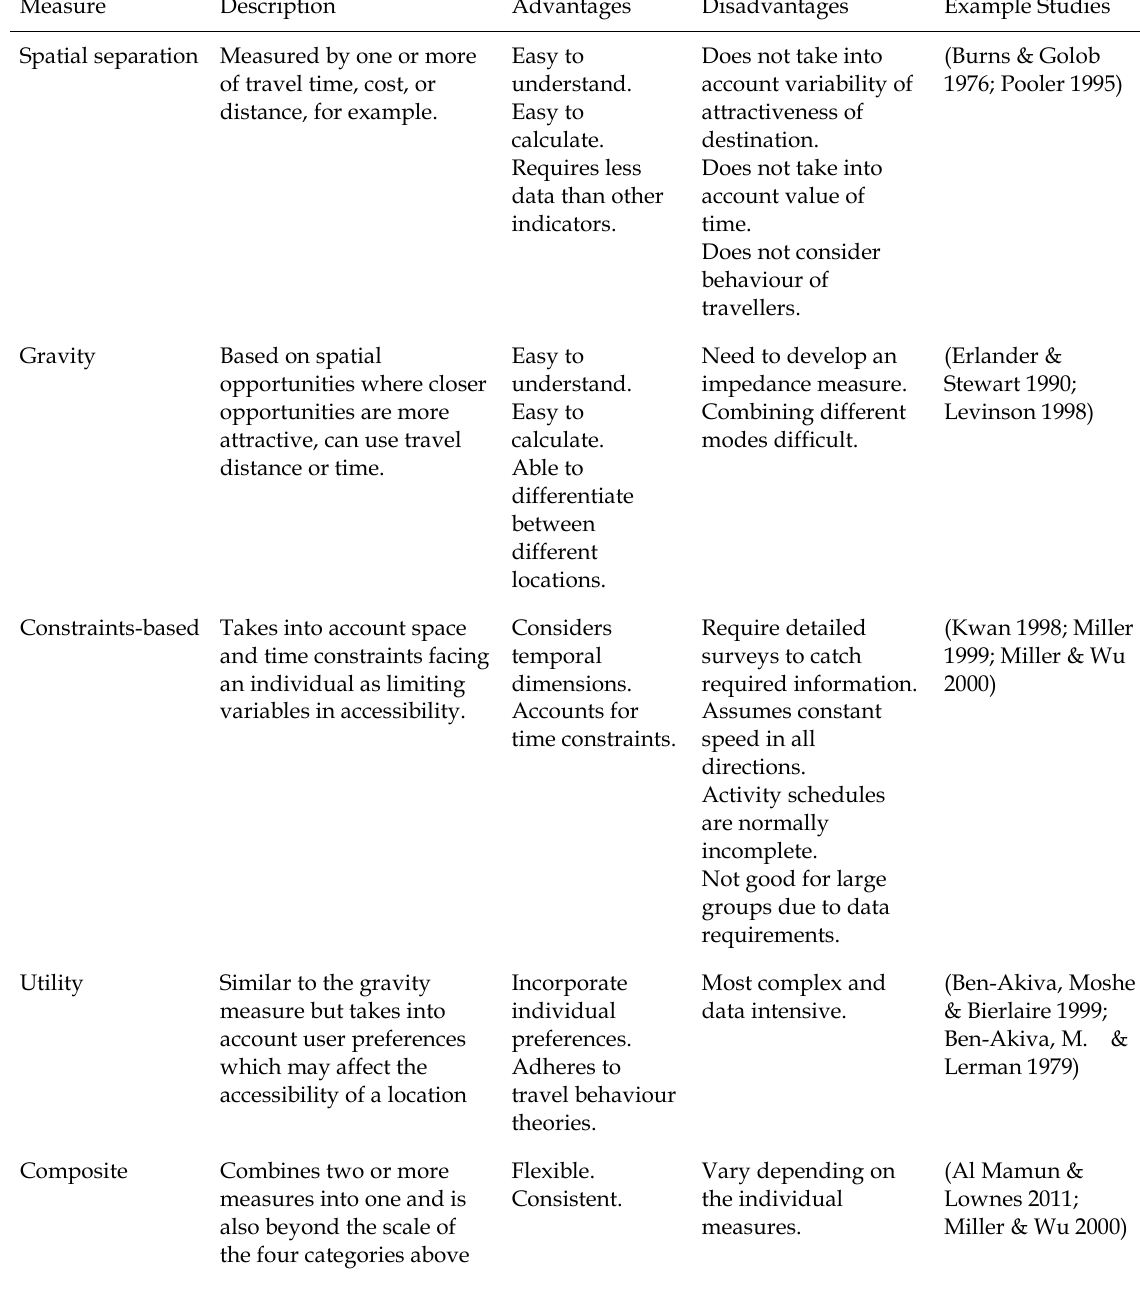
Table 1. A summary of advantages, disadvantages and theory of commonly used accessibility